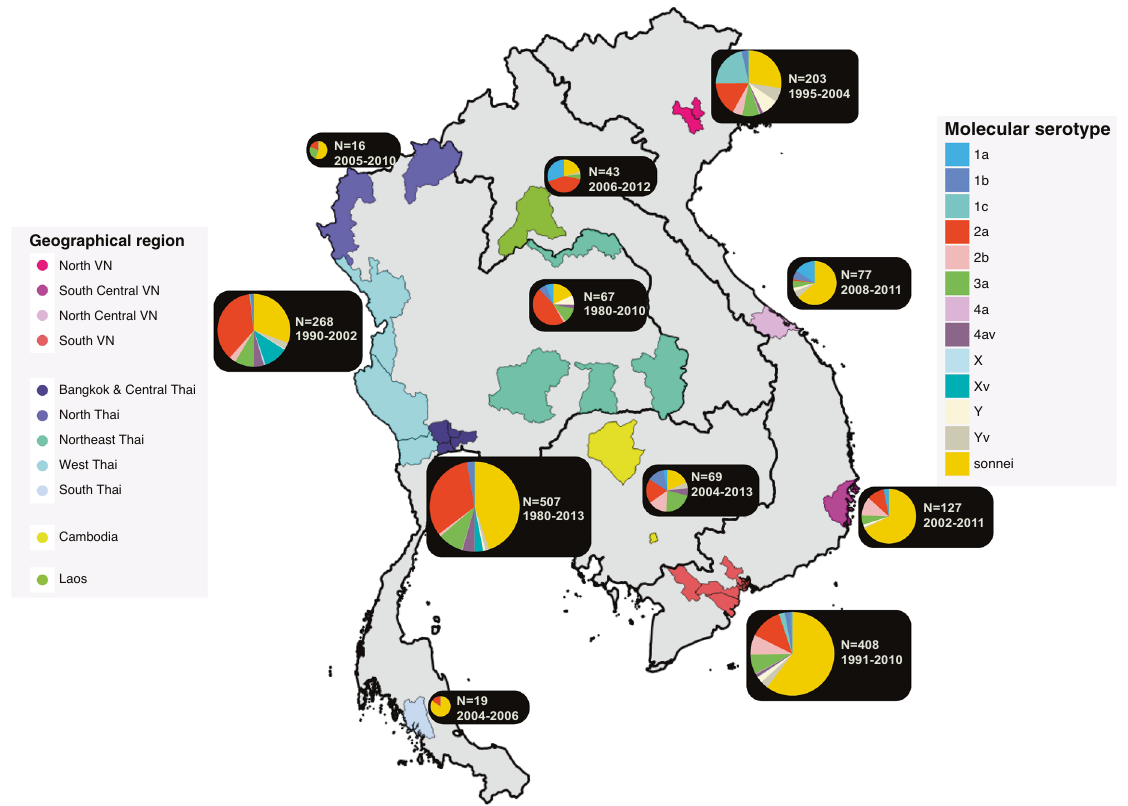
Fig. 1 Overview of Southeast Asian Shigella genome sequences used in this study. The fi gure displays a map of the four Southeast Asian countries where the Shigella samples originated (Thailand, Cambodia, Laos, Vietnam). Cities/provinces with collected Shigella sequences are highlighted with respect to the country ’ s geographical divisions, except for Laos (where the capital, Vientiane, is highlighted to represent Lao isolates). These regions include Bangkok and Central Thailand (Bangkok, Nonthaburi, Samut Sakhon, Nakhon Pathom), North Thailand (Chiang Rai, Mae Hong Son), Northeast Thailand (Nong Khai, Ubon Ratchathani, Surin, Nakhon Ratchasima), West Thailand (Tak, Kanchanaburi, Ratchaburi), South Thailand (Trang), Cambodia (Phnom Penh, Siem Reap), North Vietnam (Hanoi), North Central Vietnam (Hue), South Central Vietnam (Khanh Hoa), South Vietnam (Ho Chi Minh City, Dong Thap, Tien Giang, and Ben Tre). The pie charts show the proportion of all Shigella molecular serotypes, as assessed by genomic analysis (see Methods), identi fi ed from the corresponding region (see key). The size of pie charts is proportional to the total number of isolates sequenced in the region. This is accompanied by a year range indicating the duration of sampling. The four countries ’ administrative maps (accessed via http://www.diva-gis.org/gdata) were merged to create a map of Southeast Asia, using QGIS